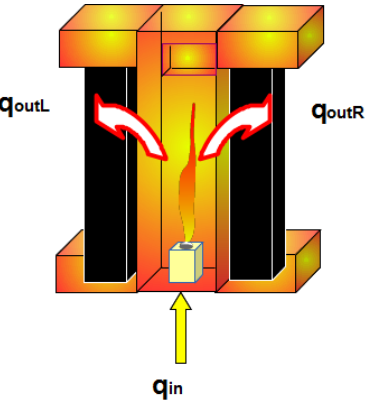
Figure 7. The scheme of heat flow to the chambers on both sides of the heating flue.